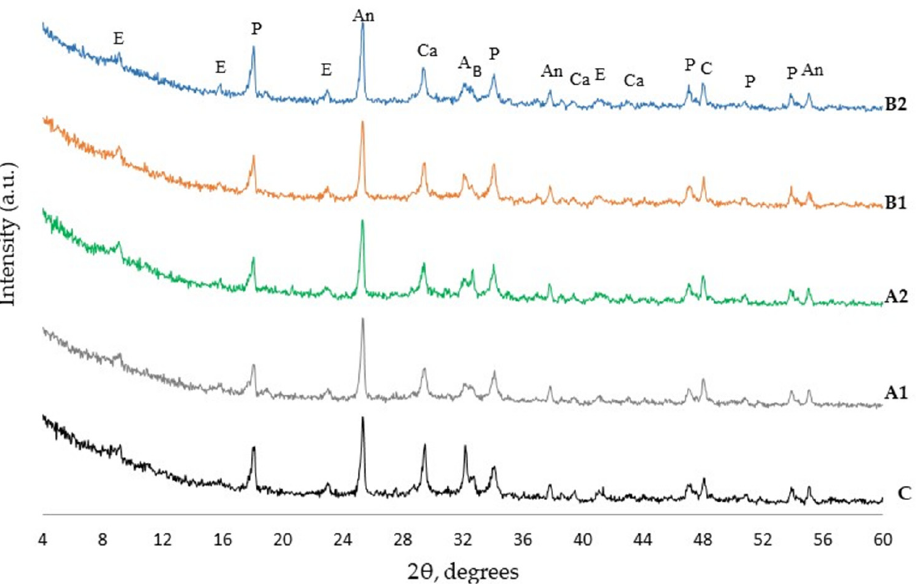
Figure 7. XRD diffractogram of hardened blended cement paste after 7 days curing (E—ettringite,